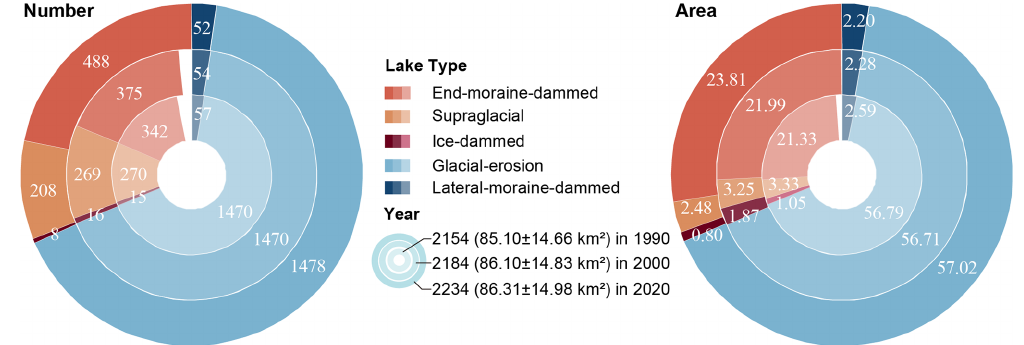
Figure 7. The number and area of different types of glacial lakes are classified based on glaciation and the nature of the dam in the study area (GLCS2). The outermost ring represents glacial lake data for 2020, the middle ring for 2000 and the innermost ring for 1990. Lake number and area in 2020 were selected as references, meaning a concept of “100%” for a complete ring. Labeled values are scaled in degrees rather than the radius of